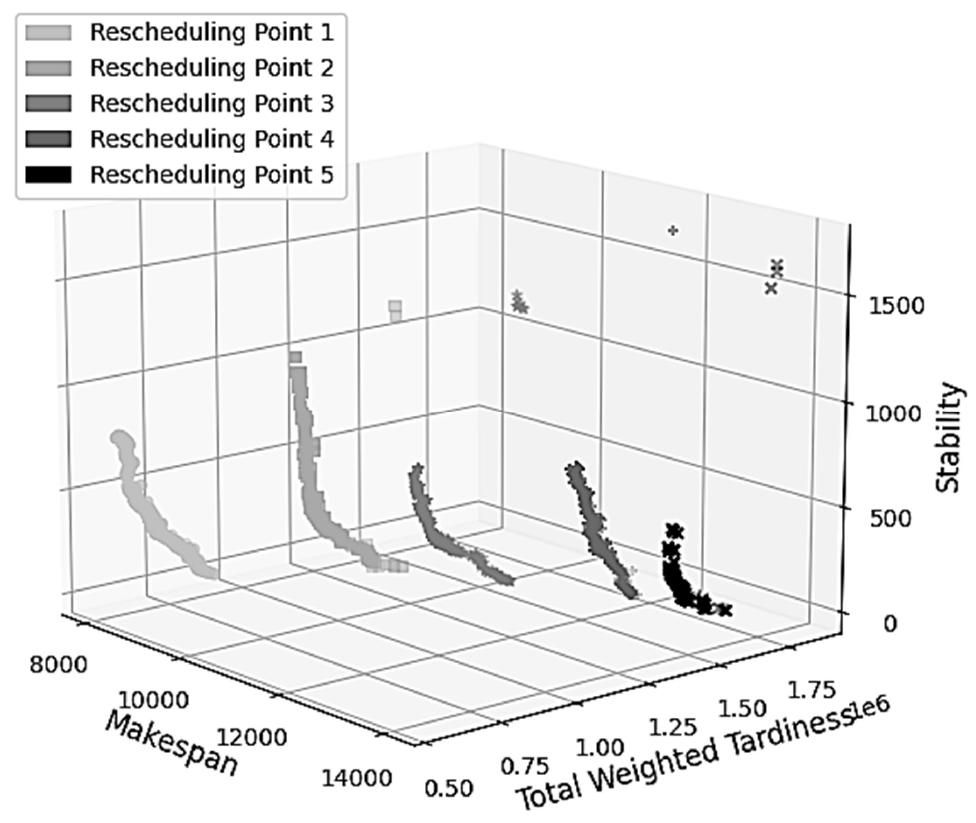
Figure 8. Dynamic Pareto evolution for HDNSGA-II in TA_100_20_6.